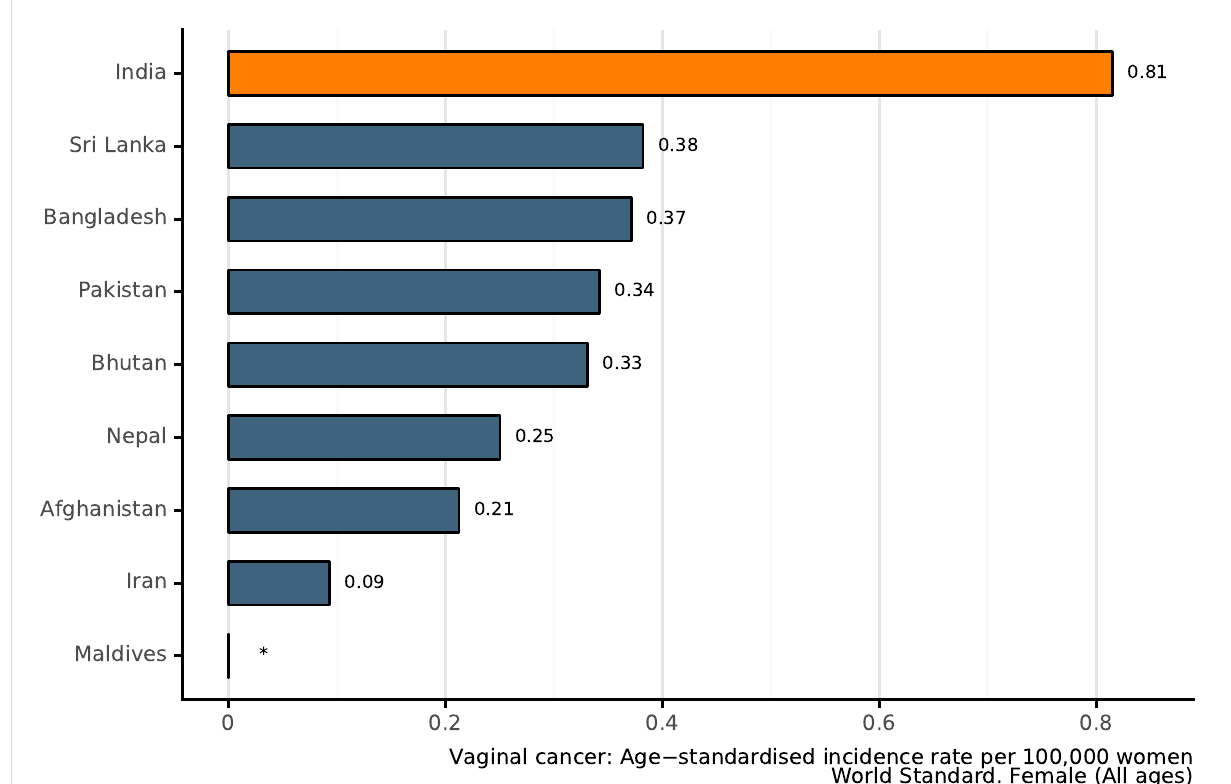
Vaginal cancer: Age standardised incidence rate per 100,000 women World Standard. Female